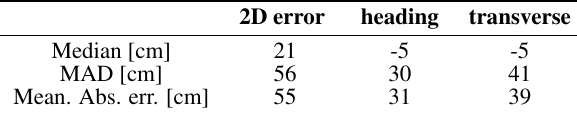
Table 2. Vision + UWB 2D positioning error and its directional characteristics.